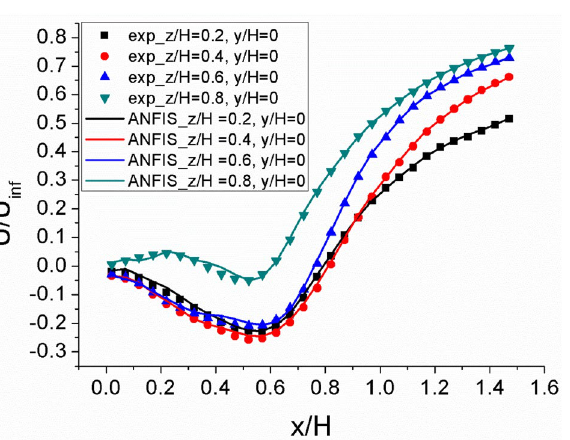
Figure 9. Comparison of the ensemble-averaged 3D streamwise vortex structures between the raw and predicted data. The spatial resolution of the raw data will increase eight-fold by ANFIS.